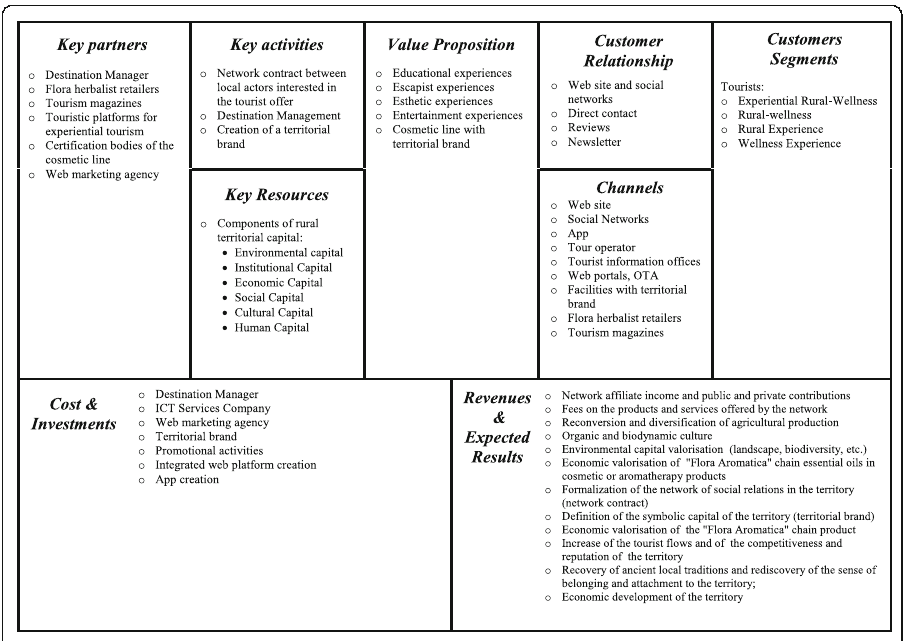
Fig. 4 The Perfume Valley Canvas Business Model. Source: our elaboration on a direct survey of Osterwalder and Pigneur (2010)